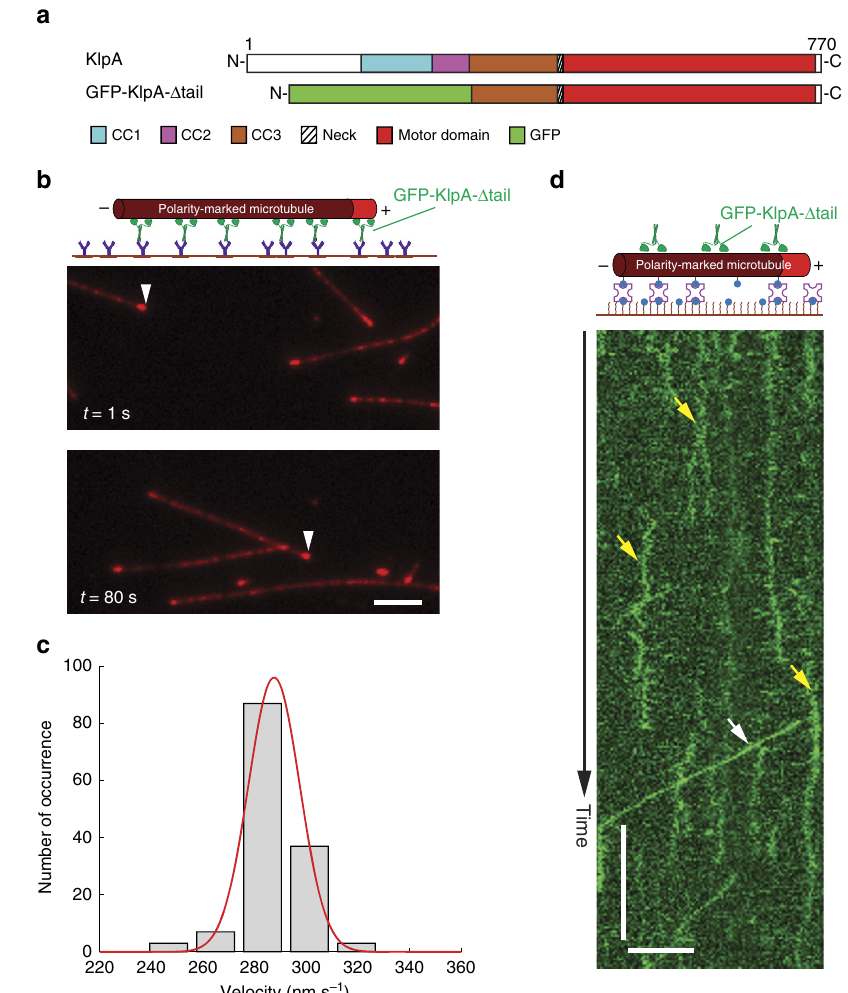
Figure 3 | Plus end-directed processive motility of KlpA on single microtubules requires its N-terminal nonmotor microtubule-binding tail. ( a ) Schematic diagrams of the full-length KlpA and the recombinant GFP-KlpA- D tail. GFP-KlpA- D tail contains a polyhistidine-tag (not shown) and a GFP at the N terminus, and residues 303–770 of KlpA. ( b ) Representative TIRF microscopy images of GFP-KlpA- D tail driving polarity-marked microtubules (red) to glide with the bright plus ends leading (white arrowheads). ( c ) Velocity histogram of microtubule-gliding by GFP-KlpA- D tail. Red line indicates a Gaussian fit to the velocity histogram. ( d ) Example kymograph showing that individual GFP-KlpA- D tail molecules (yellow) exhibit nonprocessive movement on a single polarity-marked microtubule with a bright plus end. White arrow indicates minus end-directed movement of a rare GFP-KlpA- D tail aggregate. Scale bars, 1min (vertical) and 5 m m